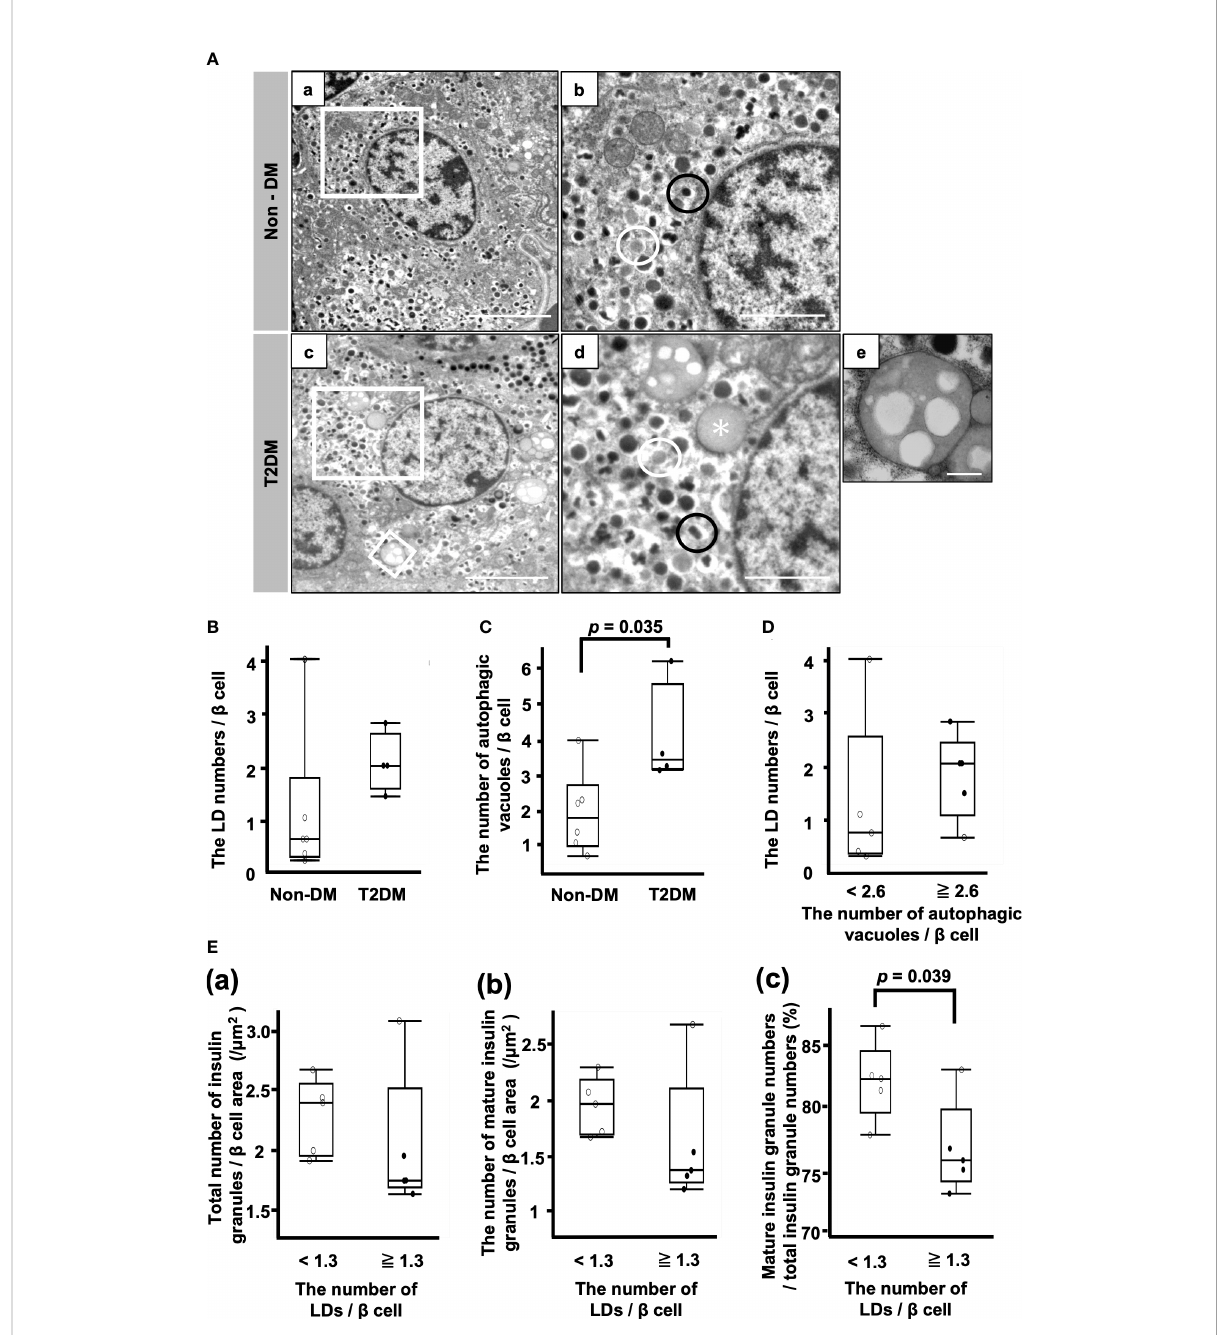
FIGURE 3 Analysis of b cells by electron microscopy. (A) Representative electron microscopy images of b cells from patients with non-DM (a, b) and T2DM (c – e) . (b, d) : Magni fi cation of the white squares in (a, c) , respectively. (e) : Autophagic vacuoles. Magni fi cation of the smaller white square in (c) . Black circle, mature insulin granule; white circle, immature insulin granule; asterisk, lipid droplet. Bars: a and c, 5 m m; b and d, 2 m m; e, 500 nm. (B) The LD numbers per b cell. (C) Autophagic vacuole numbers per b cell. (D) Comparison of LD numbers per b cell between the two groups of patients whose autophagic vacuole numbers per b cell were equal to or more than 2.6/ b cell or less than 2.6/ b cell. (E) Comparison of the total number of insulin granules (a) , the number of mature insulin granules (b) and the ratio of mature insulin granule number to total insulin granule number (c) between the two groups of patients whose LD numbers per b cell were equal to or more than 1.3/ b cell or less than 1.3/ b cell. Open circles ( ○ ), the Non-DM group (n=6); closed circles ( ● ), the T2DM group